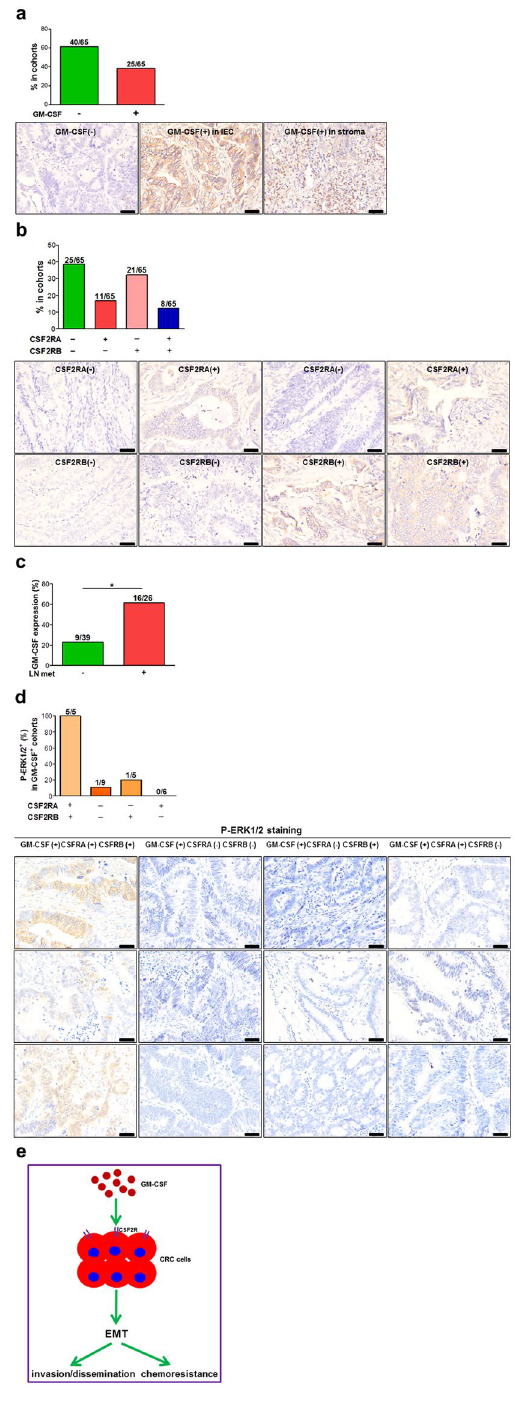
Figure 5. Intimate correlation of GM-CSF expression in CRC specimen with invasion/metastasis. ( a ) GM-CSF expression in tumor tissues of CRC patients was detected by immunohistochemistry. Representative images were shown. Scale bar: 50 μ m. The percentages of GM-CSF-positive specimen in the cohorts were calculated. ( b ) The subunit α and β of GM-CSF receptor in tumor specimen were examined by immunohistochemistry. Representative images were shown. Scale bar: 50 μ m. The percentages of CRC specimen with GM-CSF receptor-positive in cancer cells in the cohorts were calculated. ( c ) CRC patients were divided into two cohorts: with lymph node (LN) metastasis and without LN metastasis. The percentages of CRC specimen with positive staining of GM-CSF were calculated. LN met: lymph node metastasis. ( d ) The expression of phosphorylated ERK1/2 (P-ERK1/2) in CRC specimen was detected by immunohistochemistry. The percentages of P-ERK1/2-positive specimen in the indicated groups were calculated. Representative images (three cases per group) were shown. Scale bar: 50 μ m. ( e ) The outline of our hypothesis as following: GM-CSF in tumor niches drives EMT program in receptor-expressing colon cancer cells and thereby promotes invasion/distant dissemination as well as resistance to chemotherapy. * P <